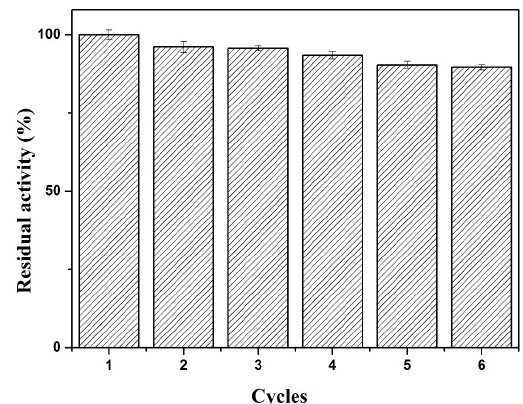
Figure 7. The reusability of the prepared DPEase nanoflower. The assay mixture contained D-fructose (500.0 mg/mL, 100.0 μ L), Co 2+ (10.0 mM, 10.0 μ L), nanoflower (0.17 mg, containing 20.0 μ g of DPEase) and Tris-HCl buffer (50.0 mM, pH 8.5, 890.0 μ L). The reaction was performed at 60 °C for 10 min. After each reaction cycle, the nanoflower was recycled by centrifugation and reused for the next run.